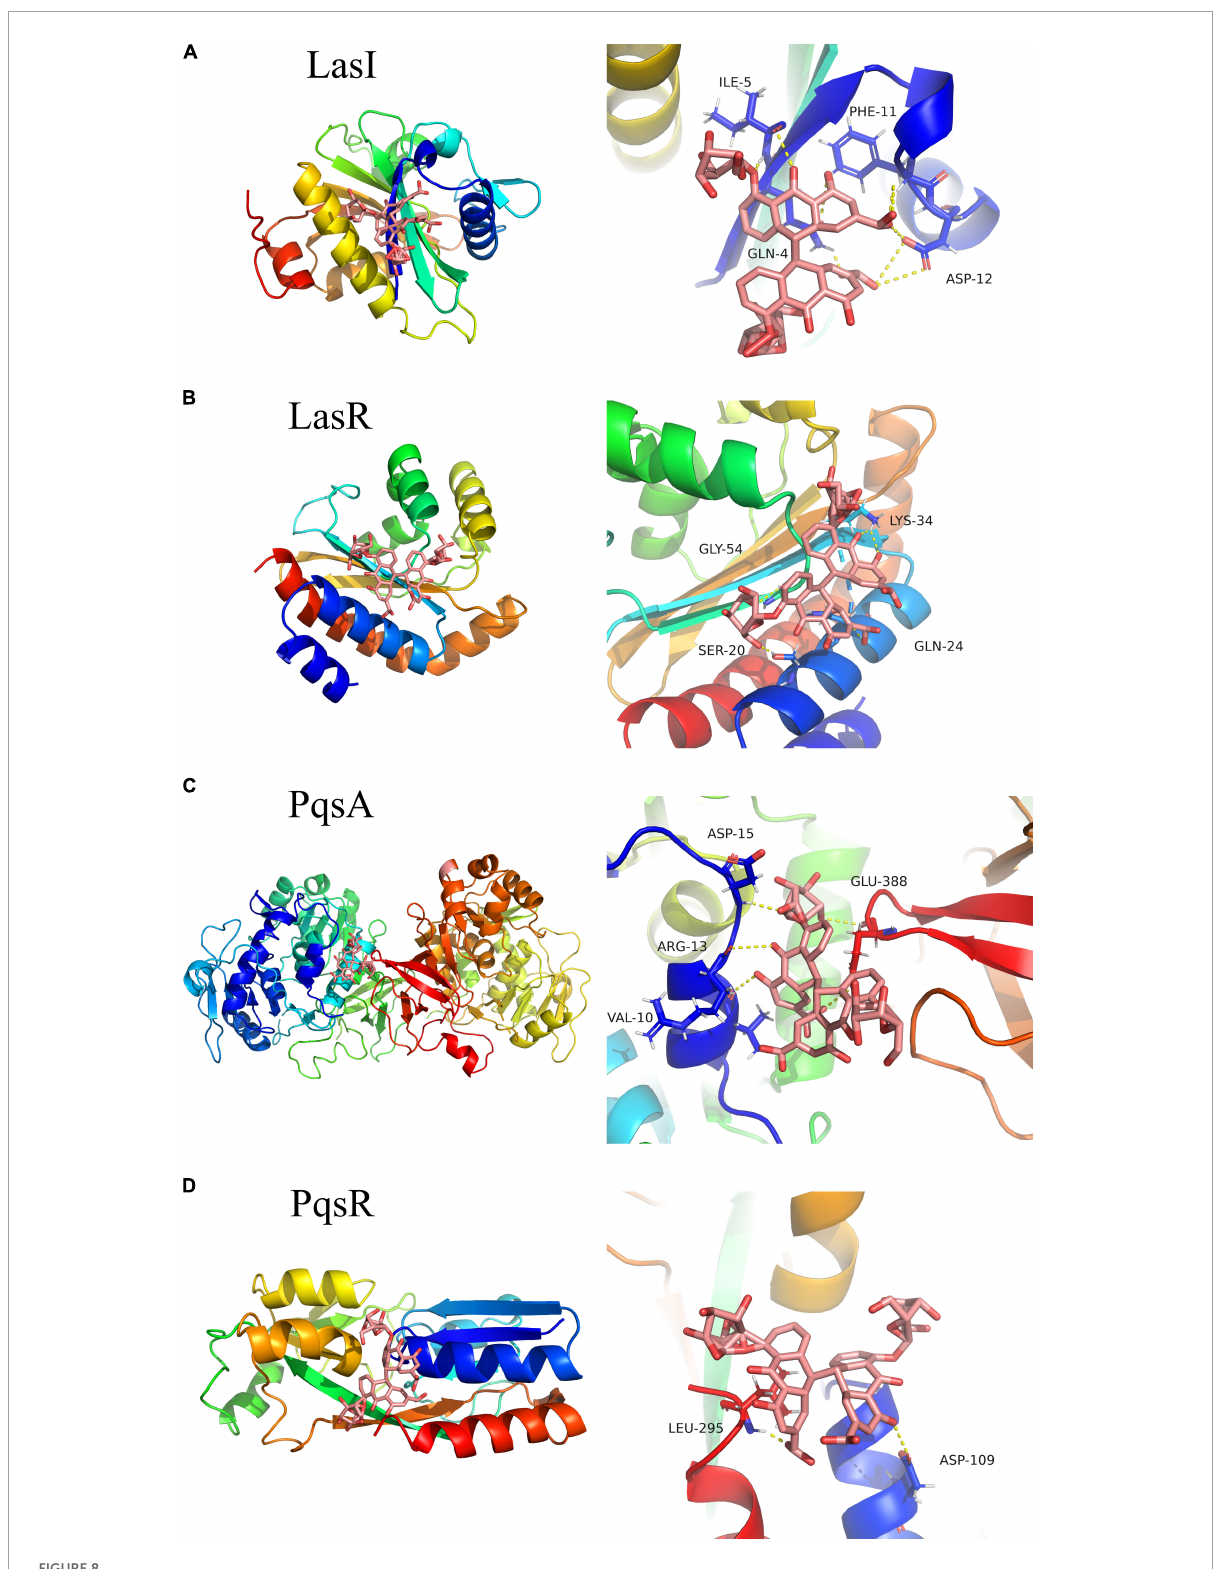
FIGURE8 Three-dimensional (left) and 3D partial enlarged graphics (right) of molecular docking analysis for SA binding to QS-related proteins of P. aeruginosa . (A) LasI, PDBID: 1RO5; (B) LasR, PDBID: 6D6A; (C) PqsA, PDBID: 5OE6; and (D) PqsR, PDBID: 4JVD.